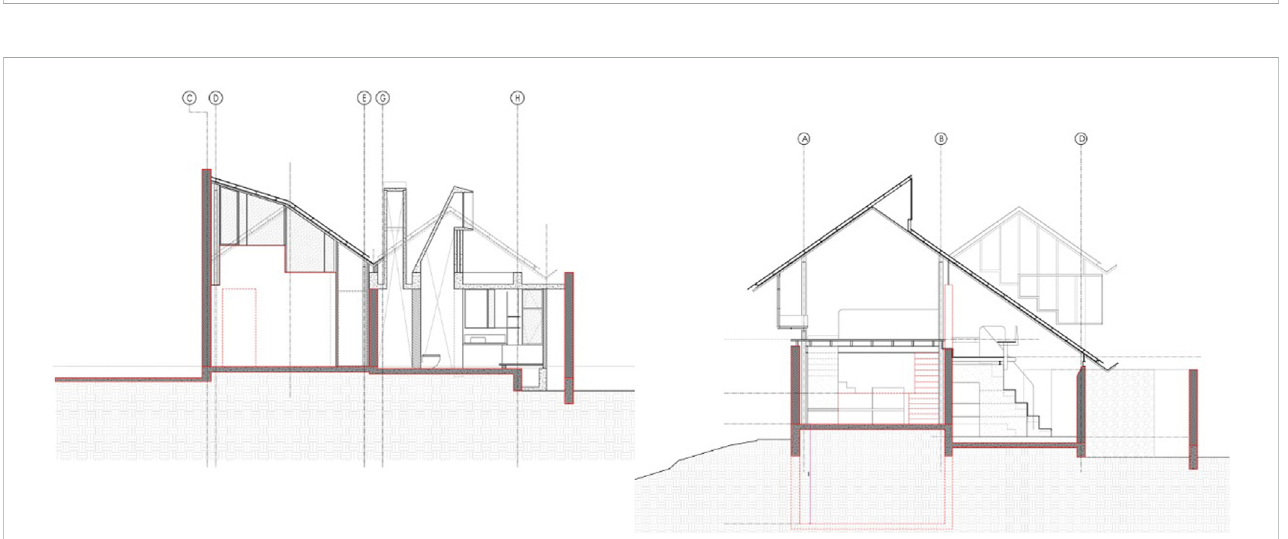
FIGURE 12 Suburban house: sectional drawings showing skylights, wind scoops and the three-dimensional spatial/environmental fi lter occupying the space left by lifting the roof over the fabric (denoted by a day bed with openable windows in the right hand side section).